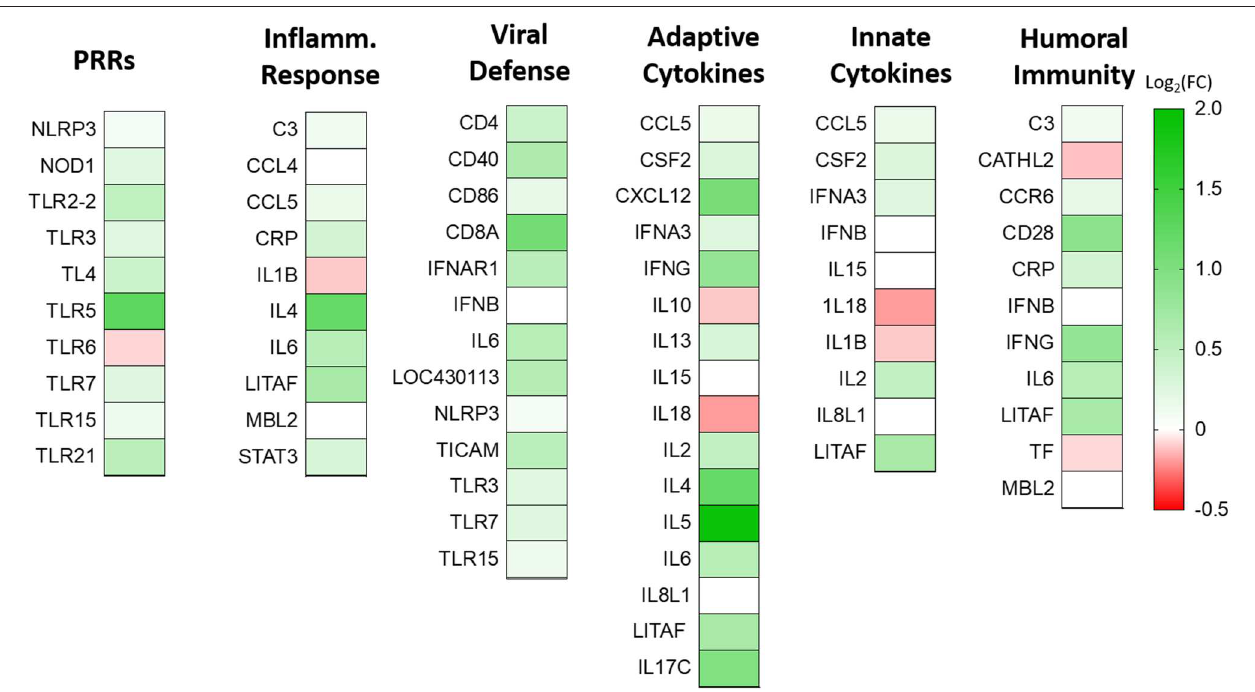
lung cells ( Figures 1 , 2 ), demonstrating that AIV infection can effectively upregulate expression in various cells. This finding is in line with previous data in human cell lines showing